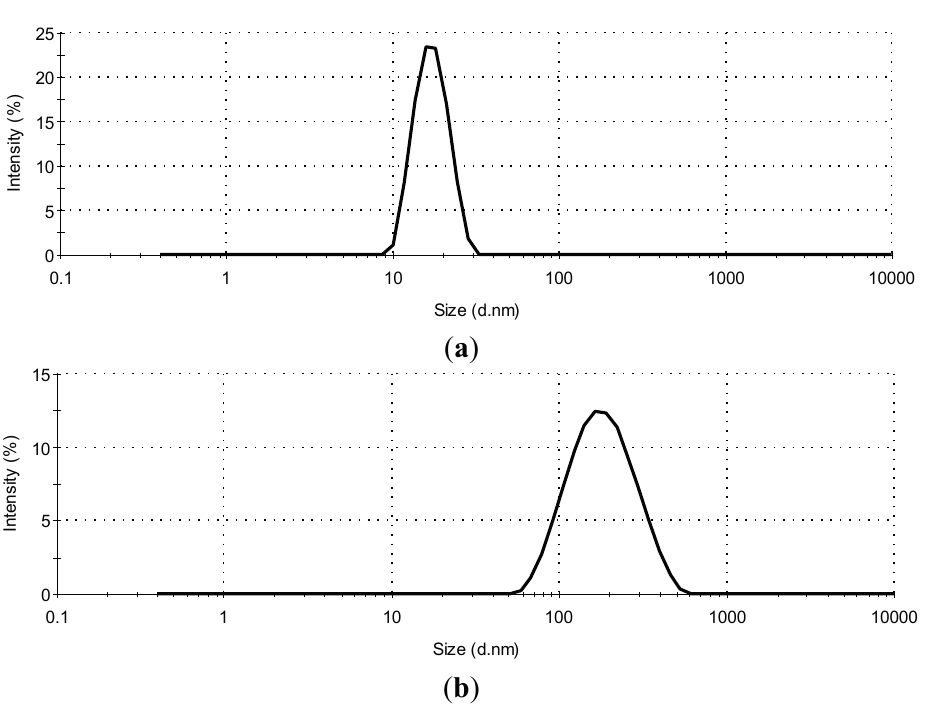
Figure 1. The droplet size distribution by intensity for SMEDDS (self-microemulsifying drug delivery systems) ( a ) and SNEDDS (self-nanoemulsifying drug delivery systems) ( b ) emulsions after dilution with water phase up to 90% w / w